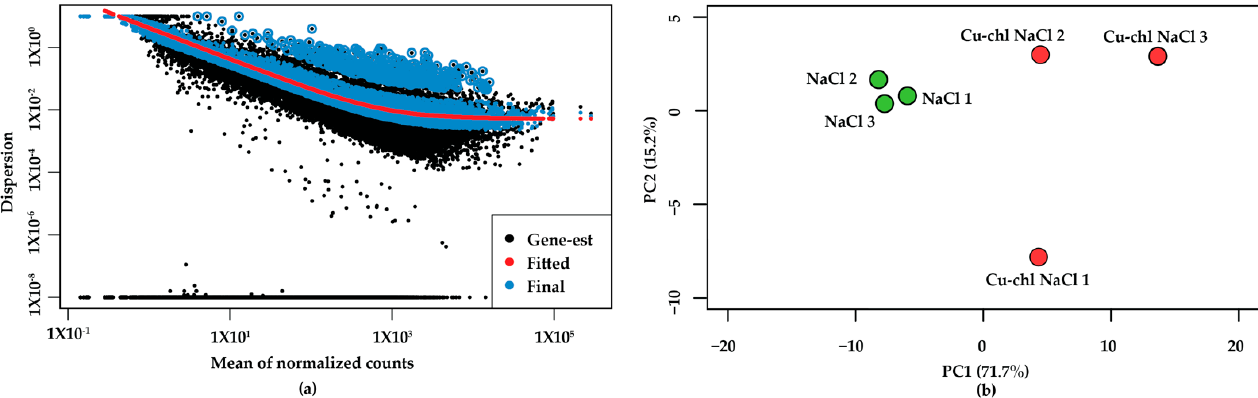
Figure 4. Distribution of samples and variation among the replicates and throughout the treatments: ( a ) dispersion/variation of each gene among the replicates. Black dot and blue circle designate, respectively, the mean of normalized counts and variation of a gene. Strongly clustered data points around the red line suggests that data are well distributed and fit for differential gene expression (DGE) analysis ( b ) principal component analysis (PCA) plot of relative distribution of biological replicates and the treatments. PCA1 and PCA2, respectively, denote the highest and second highest variation of samples among the treatments. All three replicates for NaCl showed strong grouping, where Cu-chl NaCls were dispersed on the plane. However, note the low percent of variation with PCA1, which indicates, there were no extreme outliers throughout the samples.